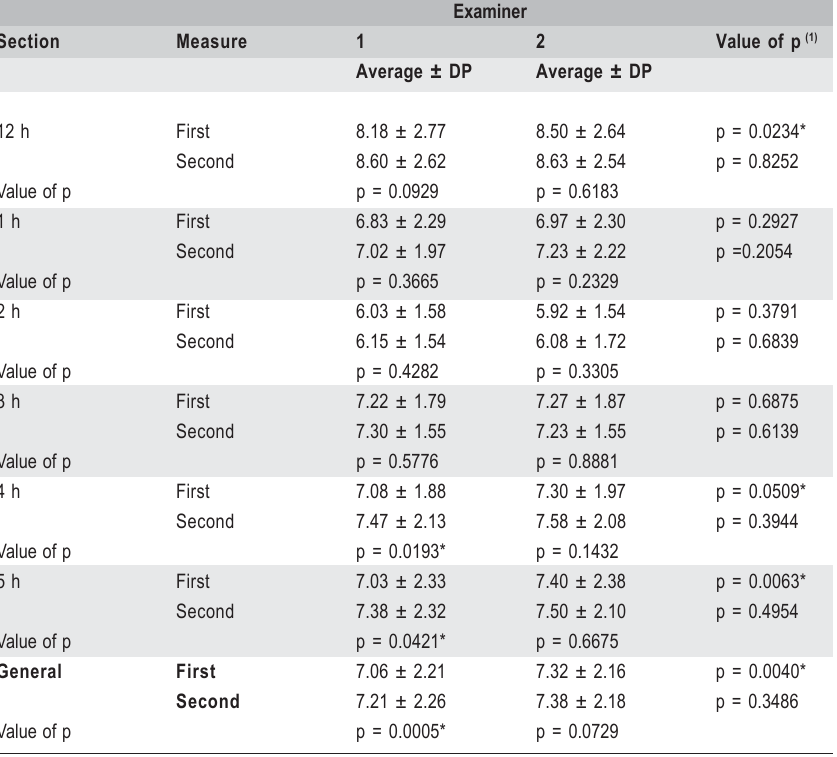
Table 2. Measurements in millimeters and standard deviation of the width measurements of the left peri-orbital bone according to the measurement site, measurement, and